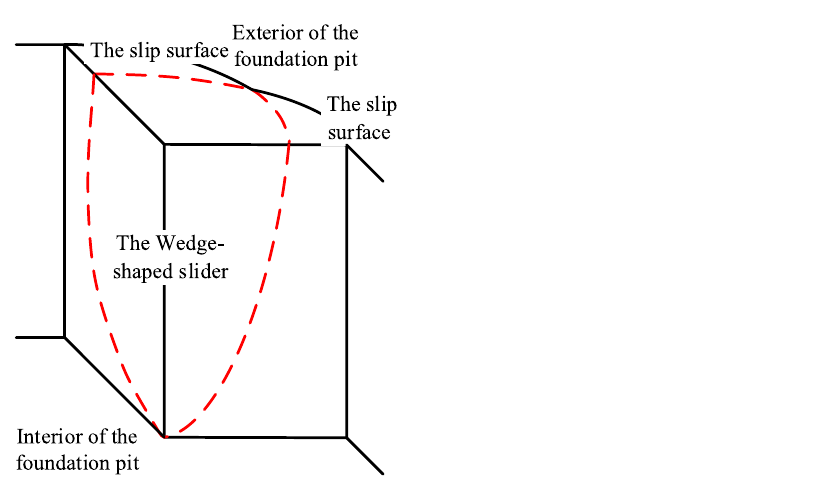
Figure 3. Analysis of failure mechanism for the external corner with long side